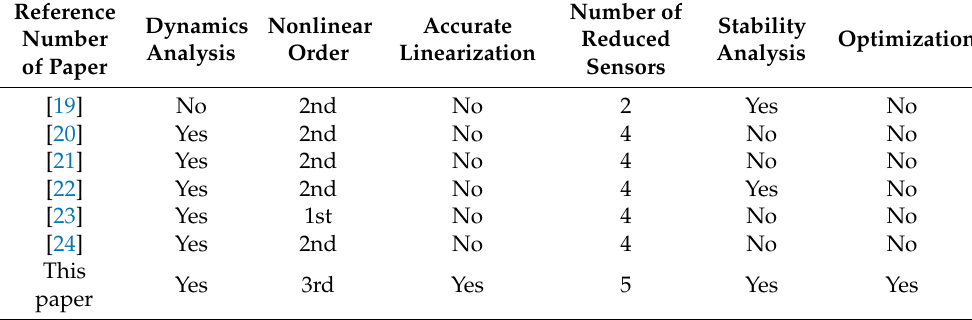
Table 1. Observer features coverage.